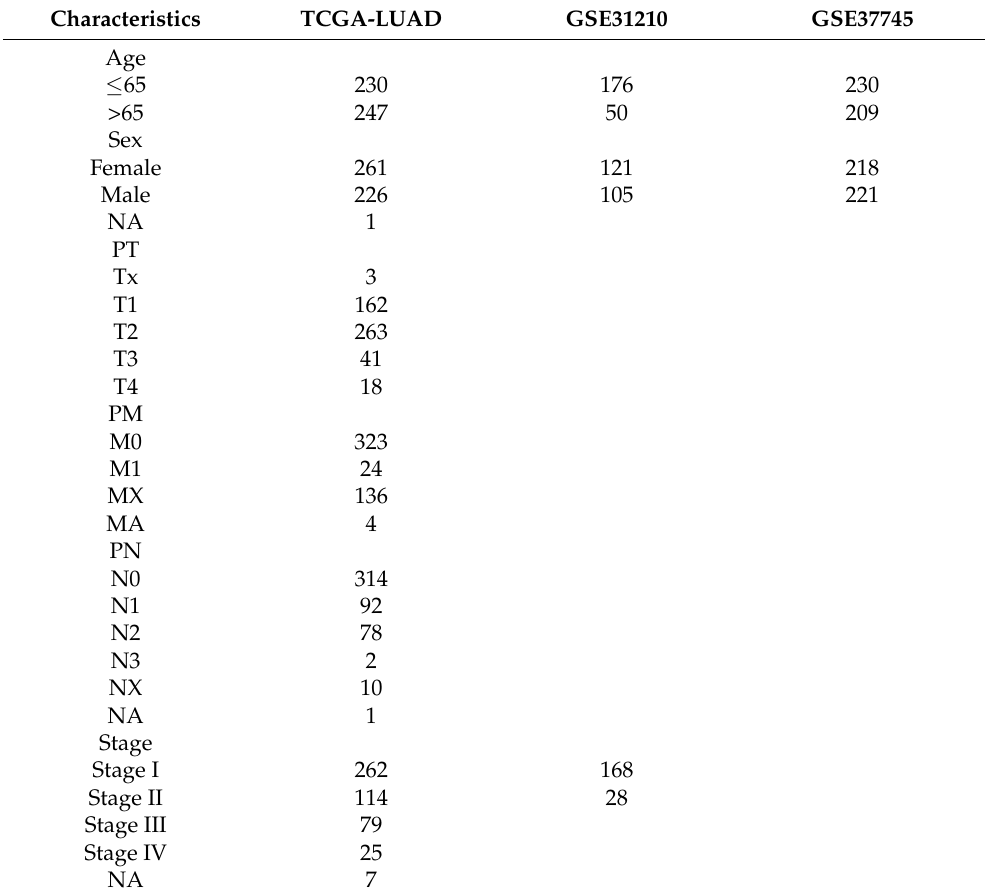
Table 2. The clinical characteristics of the